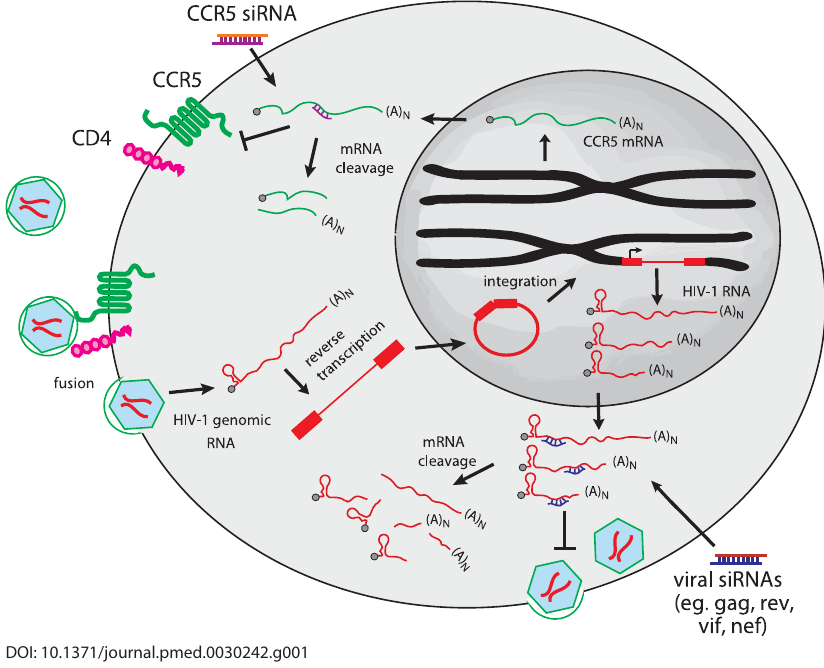
Figure 1. Possible Targets for Suppressing HIV